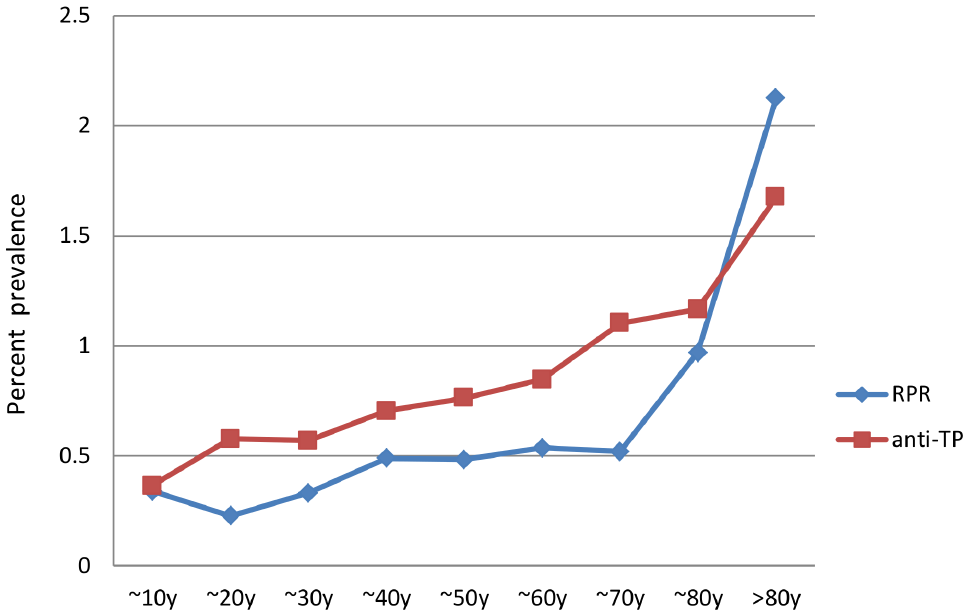
Fig 3. Seroprevalence of TP via the RPR Test and anti-TP According to Age. TP, Treponema pallidum ; RPR, rapid plasma regain test.